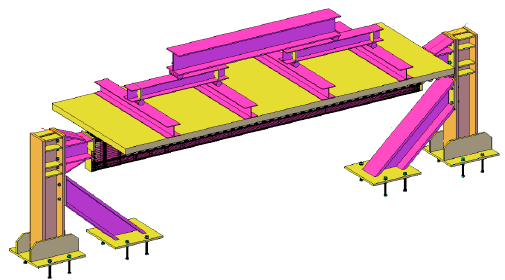
Figure 8. Proposal for test set-up for LWT-FLOOR system.